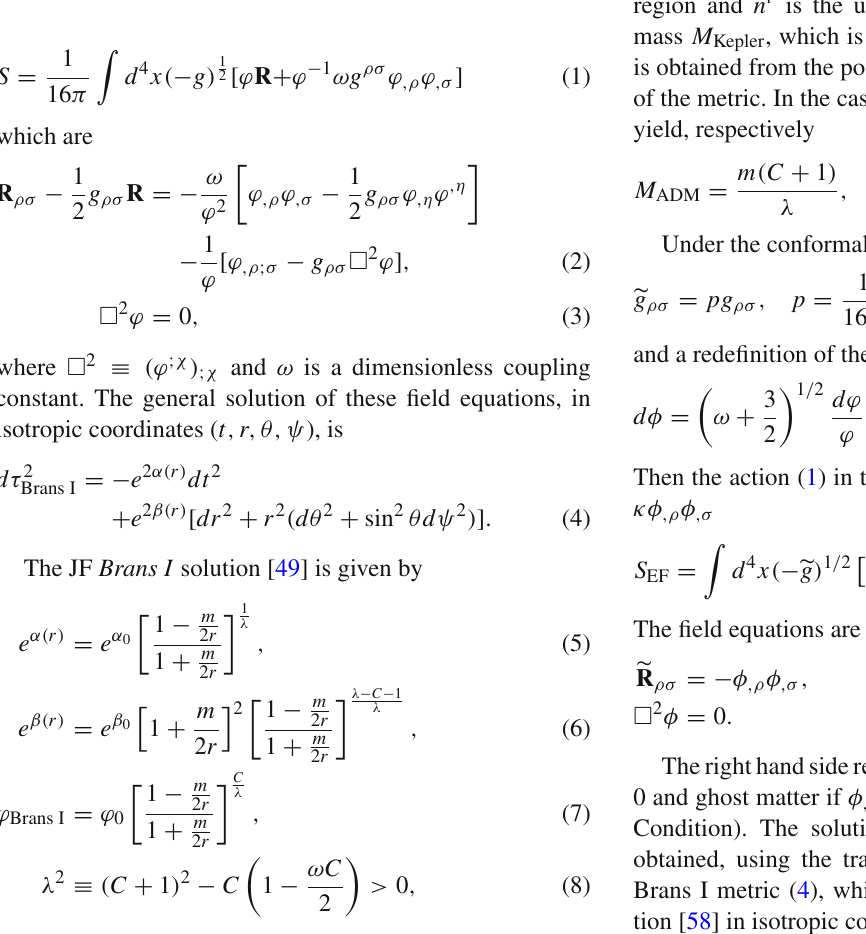
Fig. 1 The inter-convertibility of different